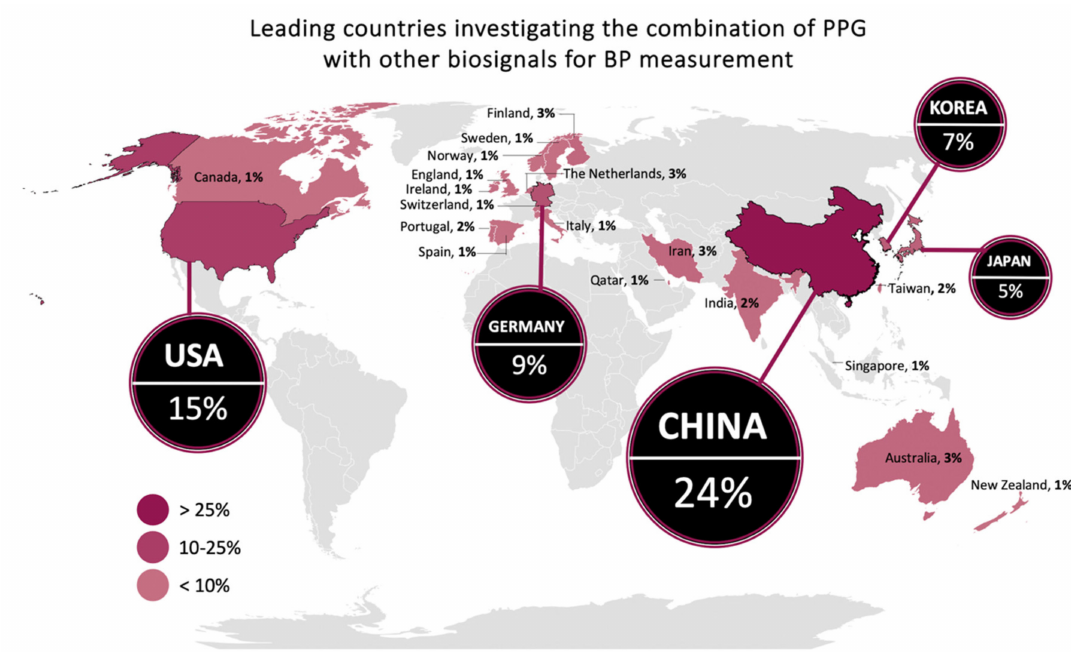
Figure 3. Global distribution of scientific articles that discussed PPG signals in combination with other biosignals to assess blood pressure from 2010–2019. The top five contributing countries are China (22), USA (14), Germany (8), Korea (6), and Japan (5), which collectively produced 67% of the publications. The number of publications per country is indicated by the intensity of the color, with darker colors representing a higher number of articles than lighter colors.